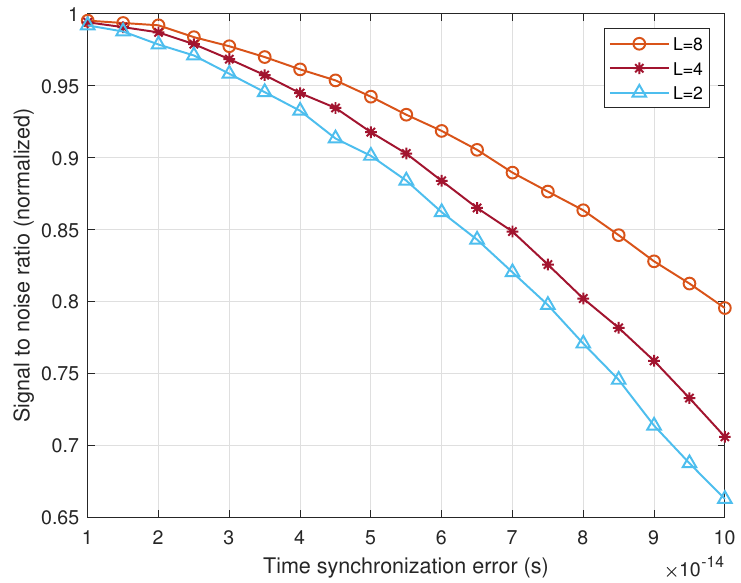
Figure 10. The impact of time synchronization accuracy on cooperative SNR where γ = 0